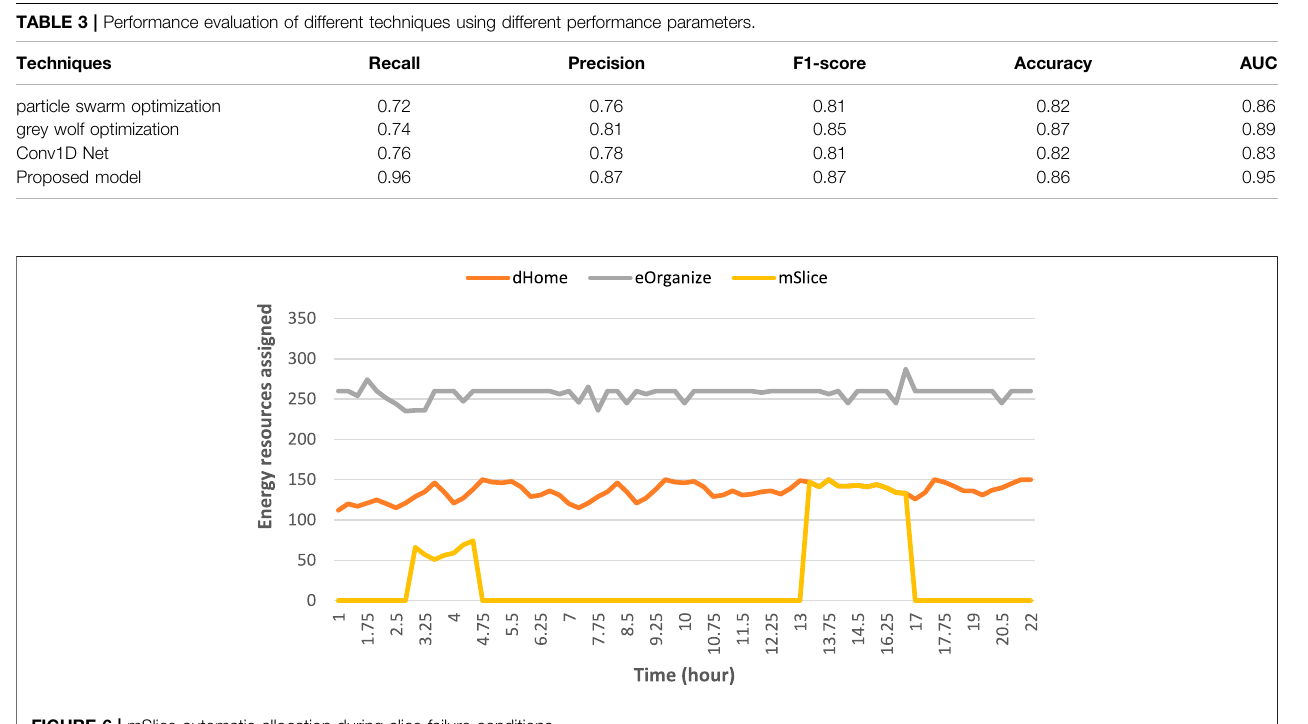
FIGURE 6 | mSlice automatic allocation during slice failure